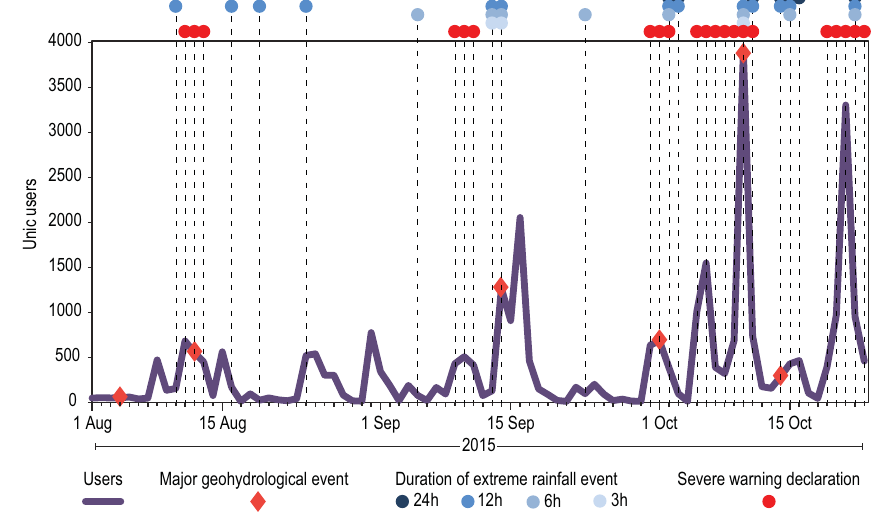
Figure 7. Number of unique Facebook page users. Days with extreme rainfall conditions are marked by blue dots, days with the major geohydrological events are marked by orange diamonds and days with severe warning declarations are marked by red